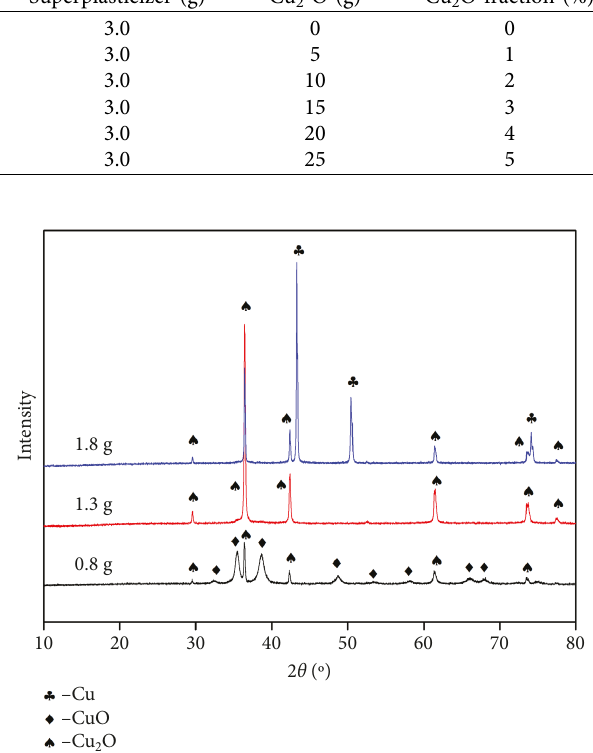
Figure 2: Effect of C 2 H 5 NO 2 dosage on the crystal structure of the reaction products (C1, C2, and